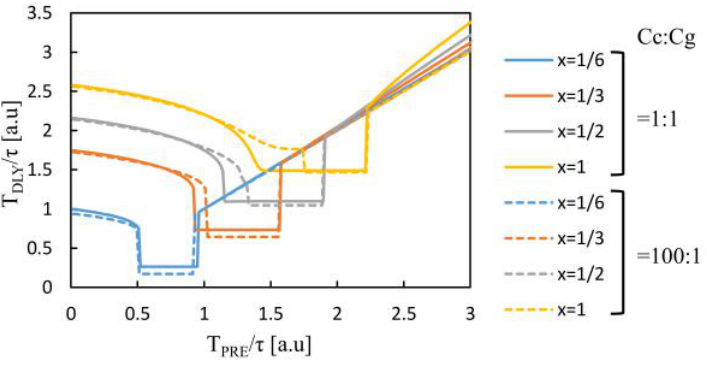
Figure 18. T DLY vs. T PRE for the models with different cap ratios under the worst case where τ varies by ± 20% ( α = 1.2, β =